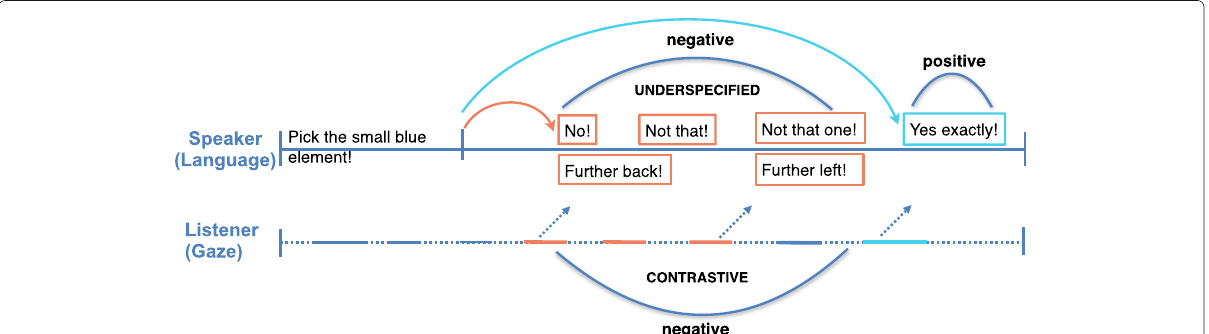
Fig. 4 Typical trial and the differentiation of feedback specificity. The red arrows represent the durations considered in the feedback analysis